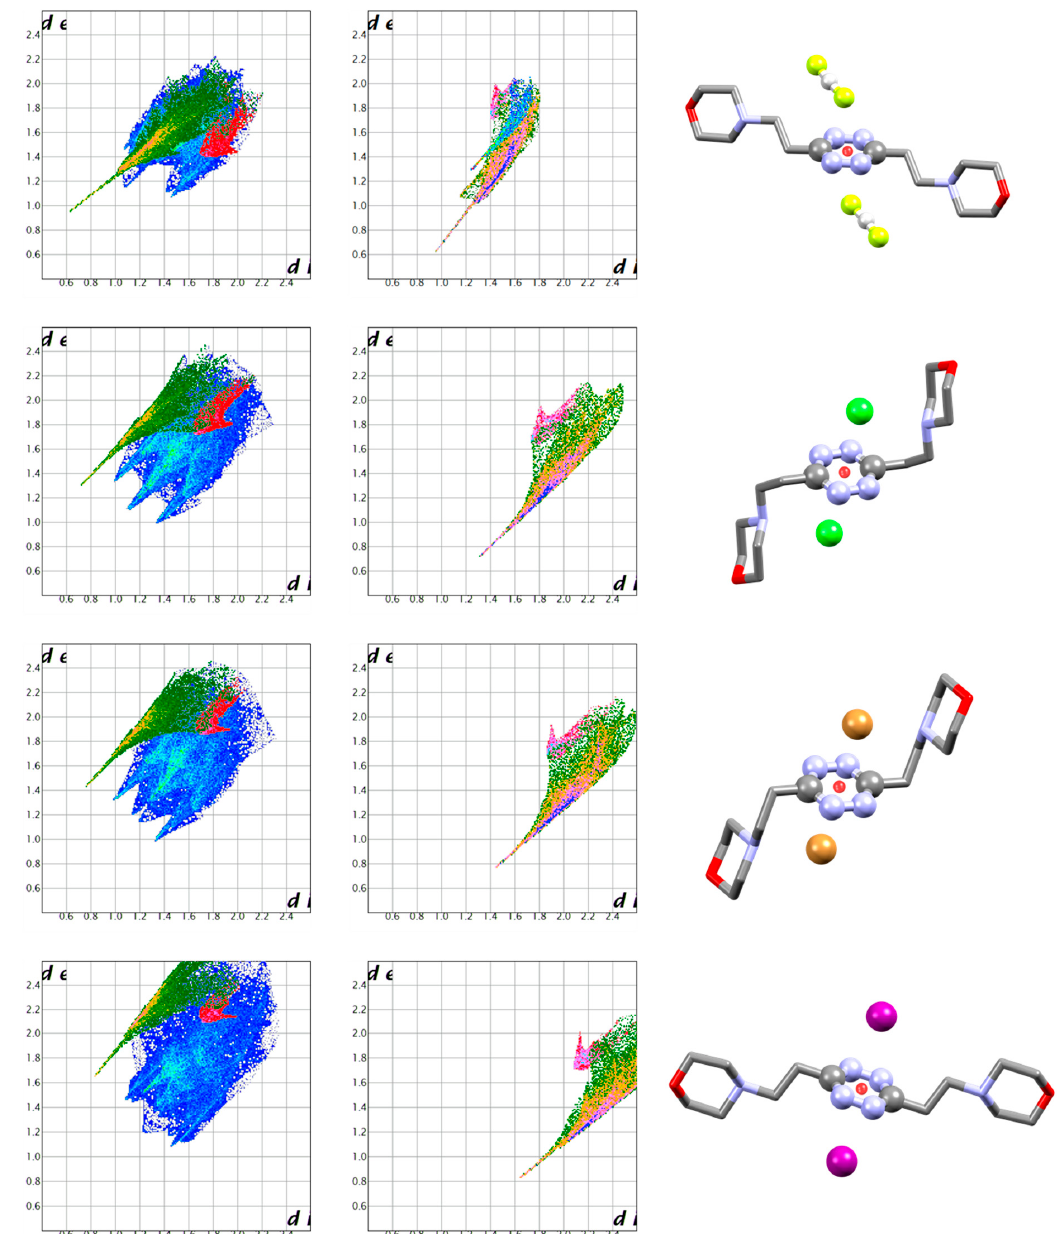
Figure 14. Complexes of the diprotonated 3,6-bis(2-morpholinoethyl)-1,2,4,5-tetrazine ligand with FHF − (CSD refcode DETRIG), Cl − (DETMOH), Br − (DETMUN) and I − (KAMLOC) anions [39]. Ligand and anion fingerprint plots, together with a brief view of the structure, are presented for each one. All anions are bound via H-bonds (green) and anion- π interactions (red). The two contributions are markedly different and clearly